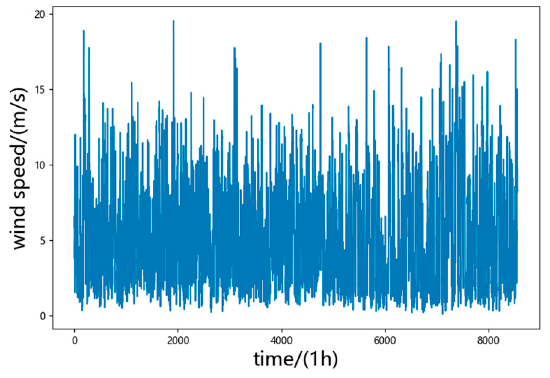
Figure 5. Original wind speed time series and rose chart.